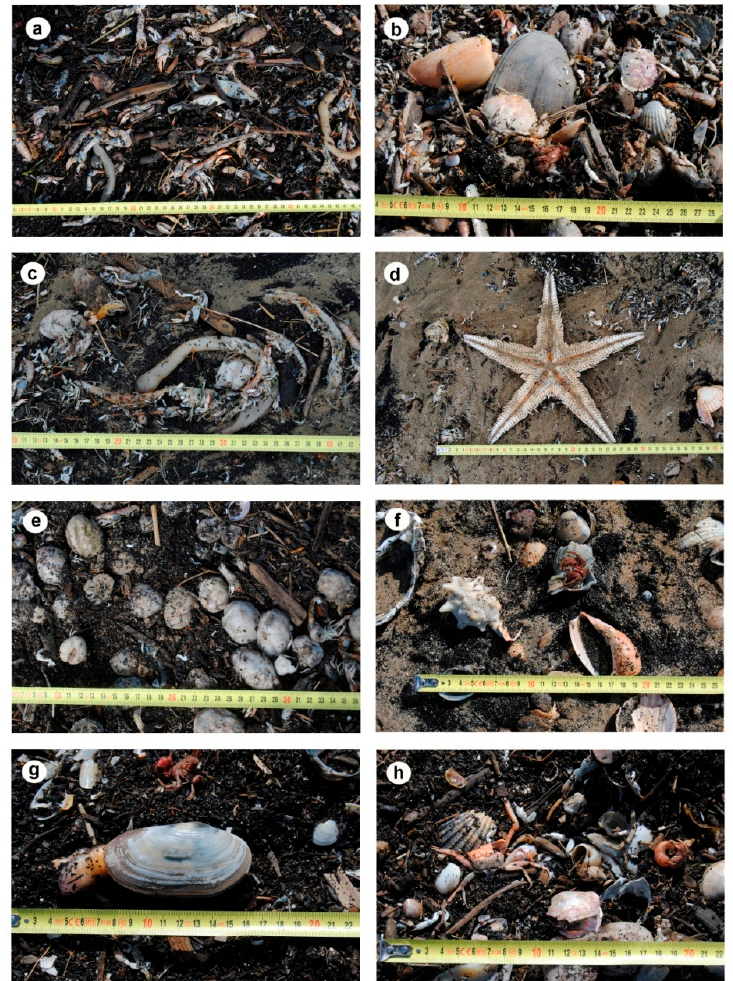
Figure 3. Main organisms observed in the mass stranding occurred at Punta Umbría beach during